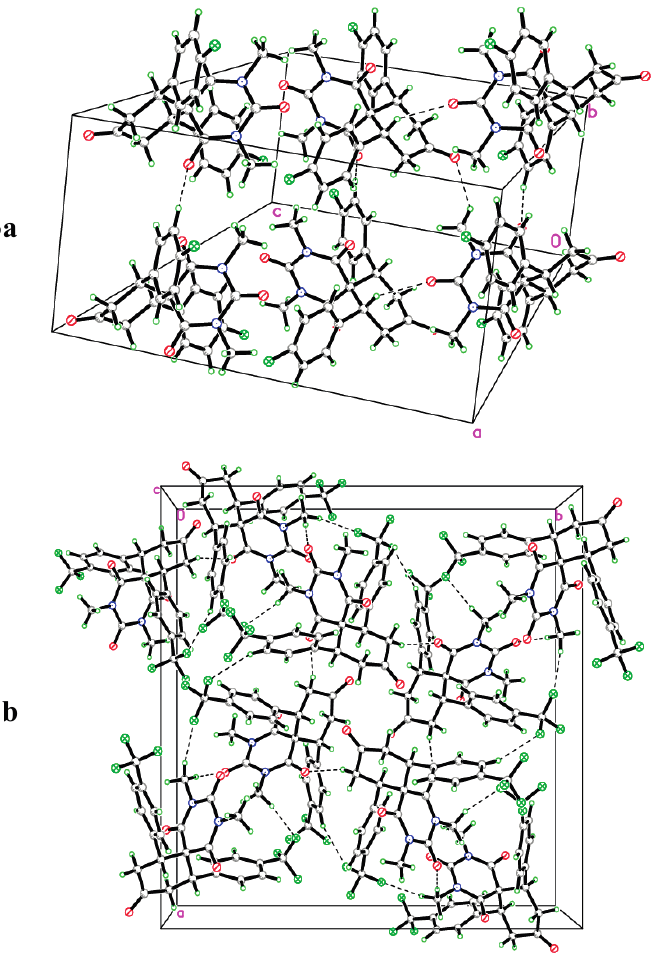
Figure 3. View of the molecular packing in compounds 3a , b